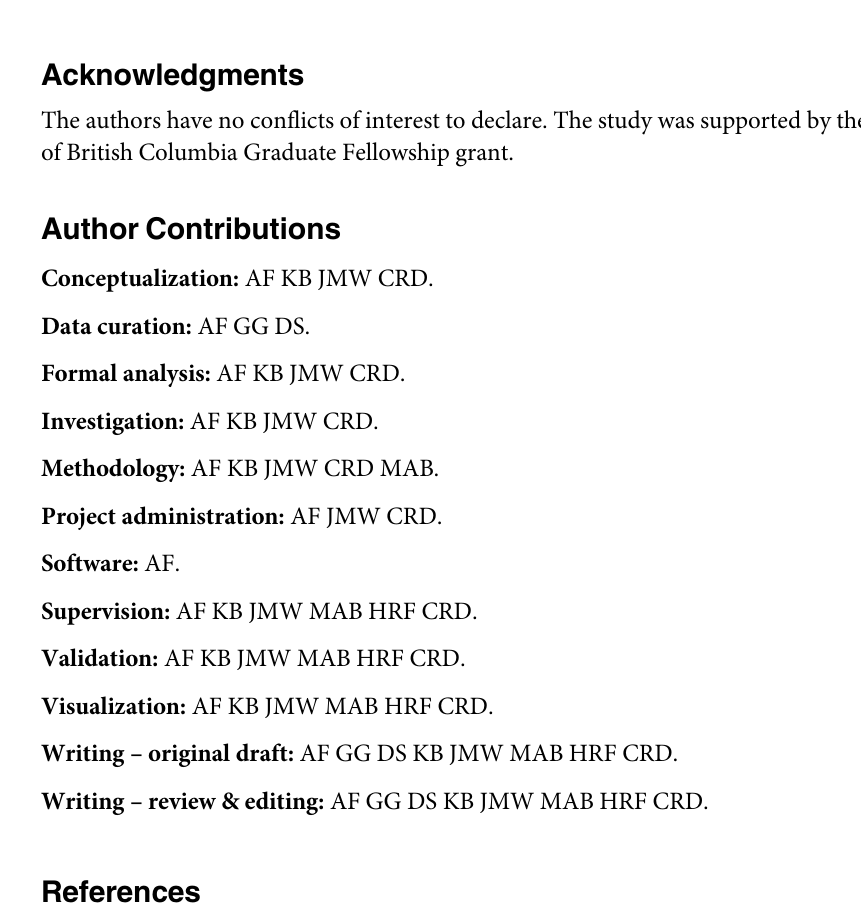
S3 Fig. Forest Plots: Hazard Ratios of included studies: Adalimumab vs. Etanercept. (TIFF) S1 Table. Excluded studies. S2 Table. PRISMA 2009 checklist.